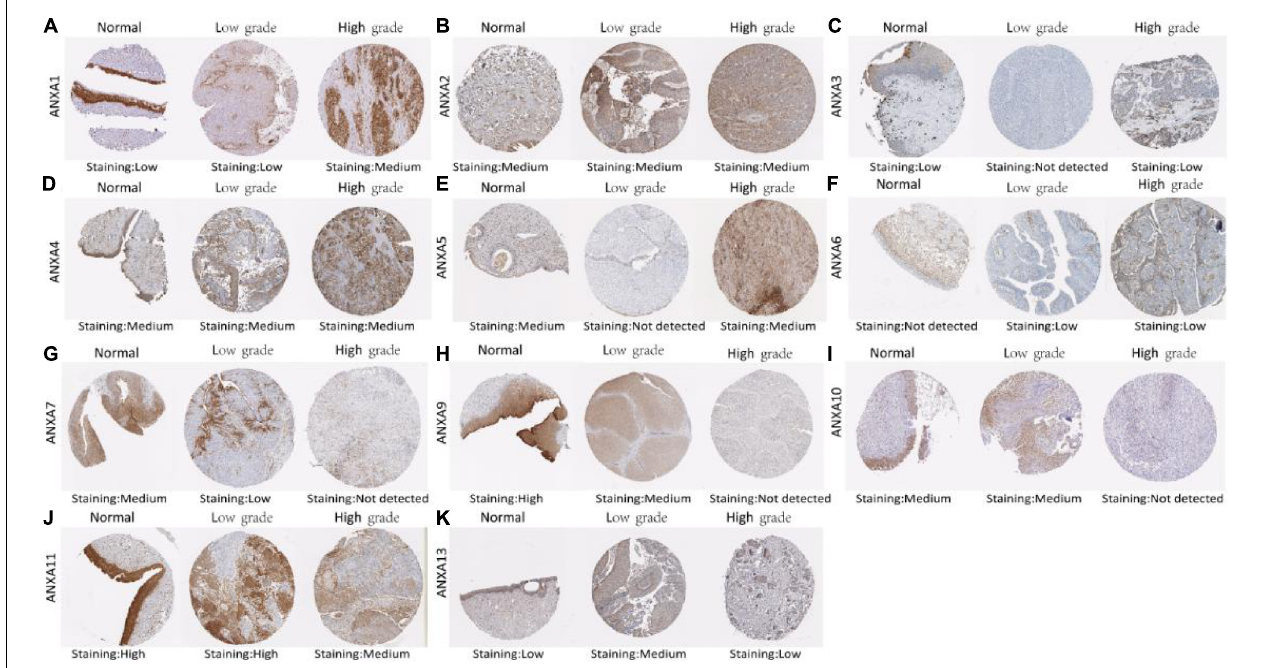
FIGURE 2 | Representative immunohistochemistry images of different ANXA family members in normal bladder tissues, low grade BC tissues and high grade BC tissues (HPS database) (A–K)